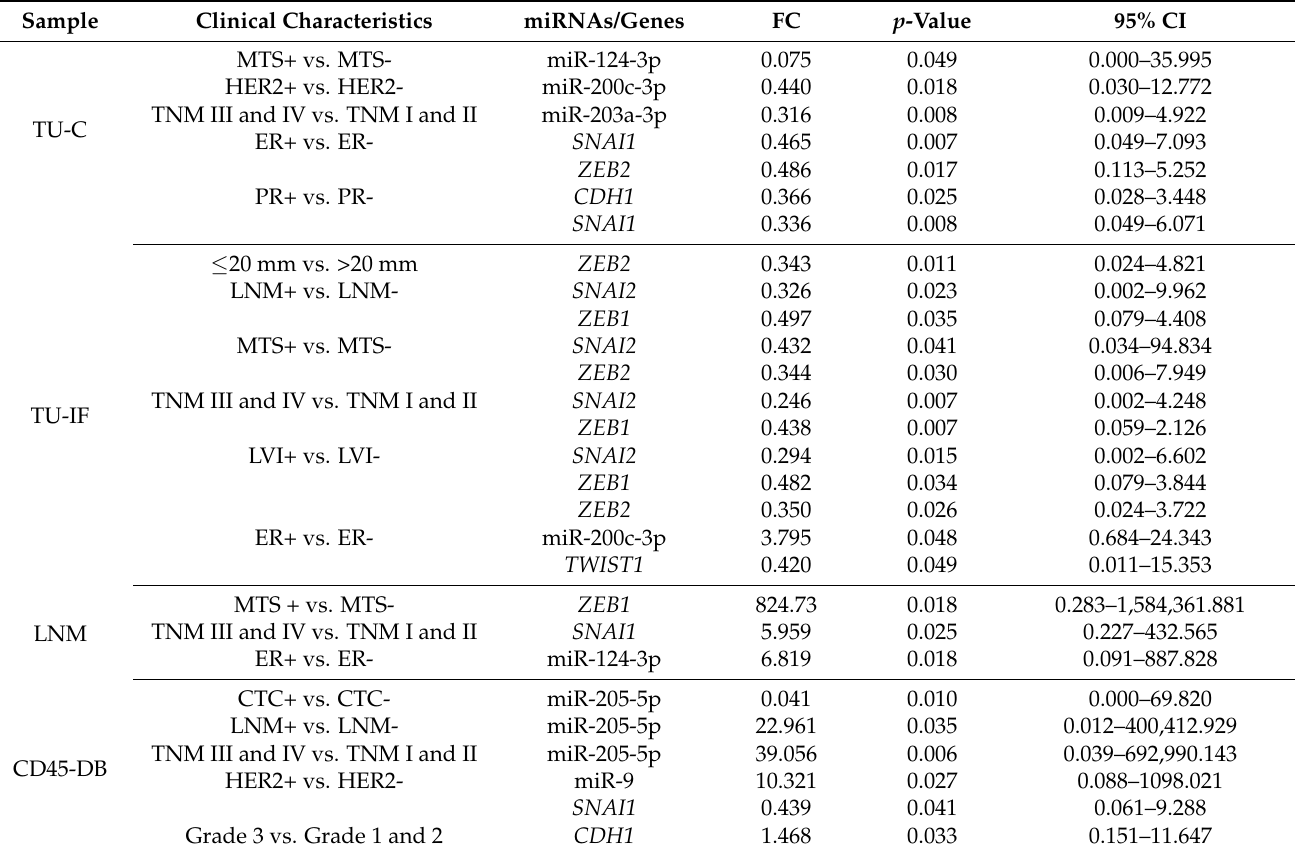
Table 3. Significant up- and downregulation of miRNA and mRNA of CDH1 , and EMT gene expression in BC patients with different clinico-pathological